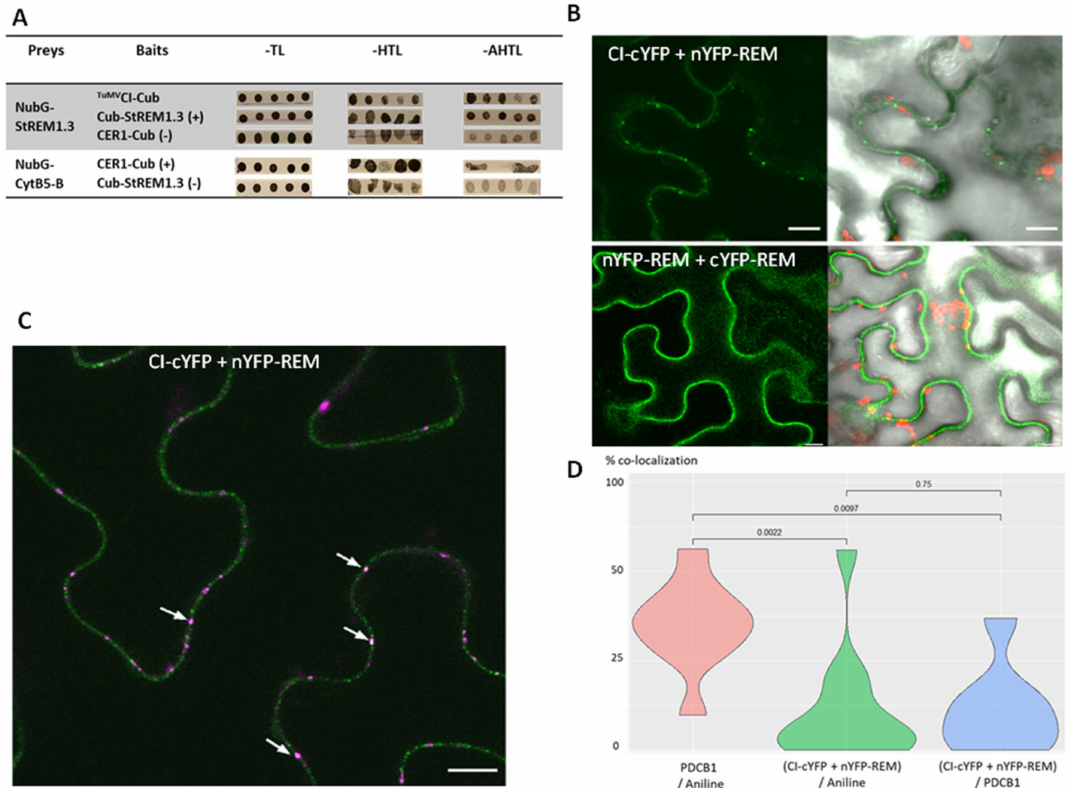
Figure 7. StREM1.3 interacts in yeast and in planta with TuMV CI: ( A ) interaction between StREM1.3 and TuMV CI in yeast split-ubiquitin assays. Five independent yeast colonies cotransformed with NubG–StREM1.3 and TuMV CI-Cub resulted in vigorous growth on synthetic dropout (SD)